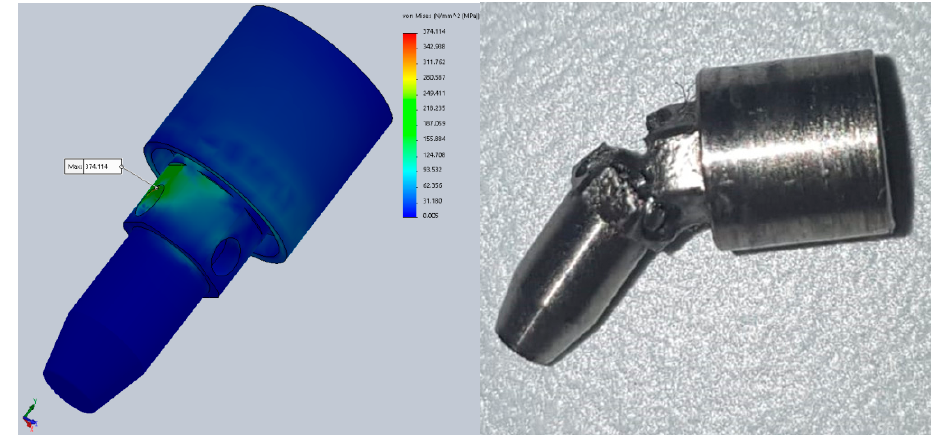
Figure 18. Comparison between FEA and physical fatigue tests .